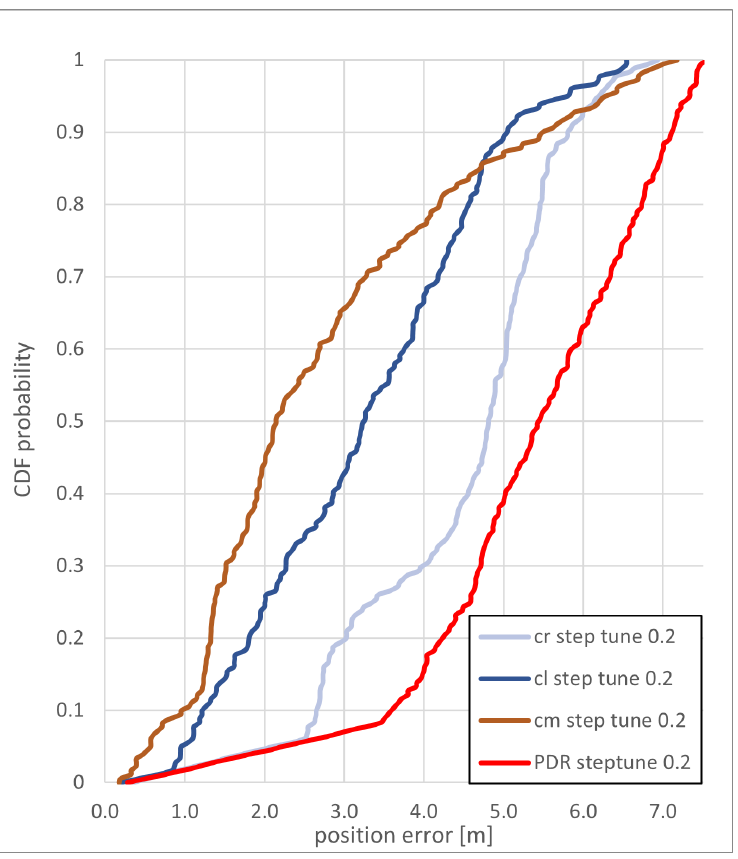
Figure 13. CDF of the positioning error of the zerotofour path with a step length correction of 0.2 m for the backtracking PF and the PDR with a step length correction of 0.2